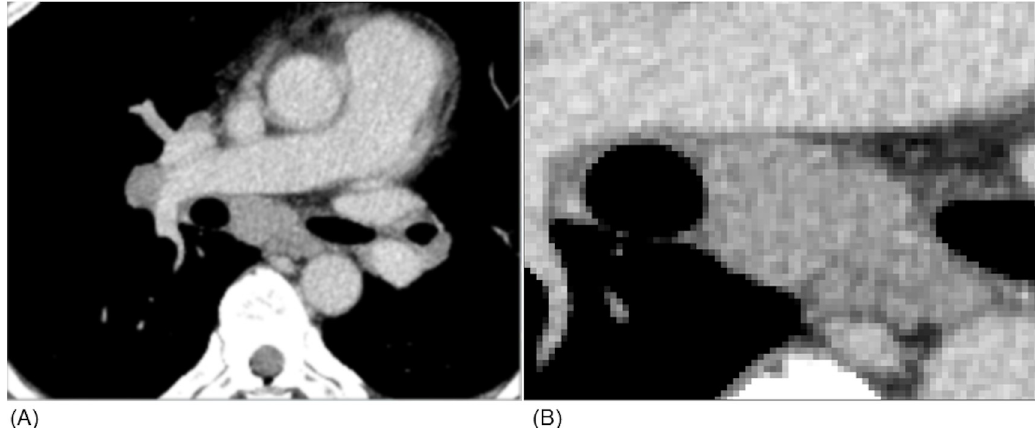
Fig 2. CT image of enlarged lymph nodes due to sarcoidosis. An enlarged mediastinal lymph node, as well as slightly enlarged hilar nodes, are shown on an enhanced CT image (A). The density of the mediastinal lymph node seems basically homogeneous (B); however, distinguishing enlargement due to sarcoidosis from that due to lymph node metastasis from small cell lung cancer on CT images only is difficult.